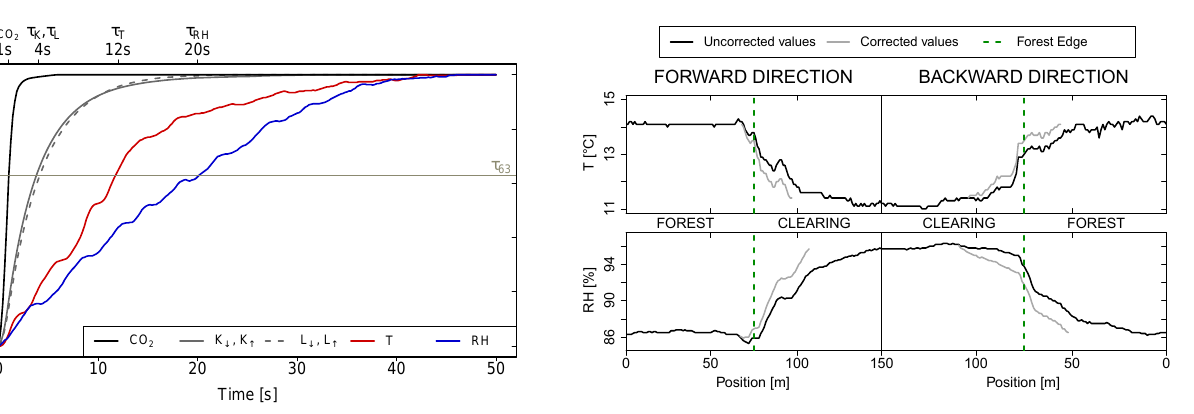
Figure 3. Measurement results of the laboratory tests of the time constant τ 63 . The small fluctuations of the temperature and humid- ity signal are caused by the turbulence under room conditions. An overview of all sensors is given in Tables 2 and 3.